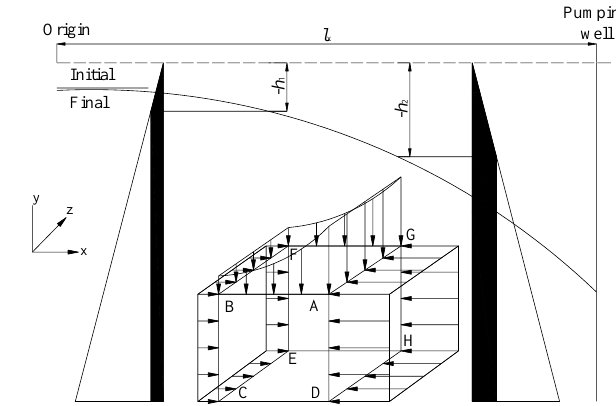
Figure 1. Stress distribution with a change in groundwater level (Budhu and Adiyaman, 2010).